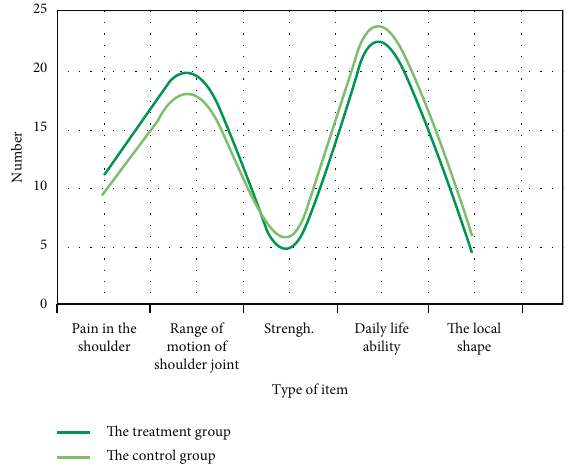
Figure 3: Comparison of clinical symptoms and evaluation scores between the two groups before treatment.